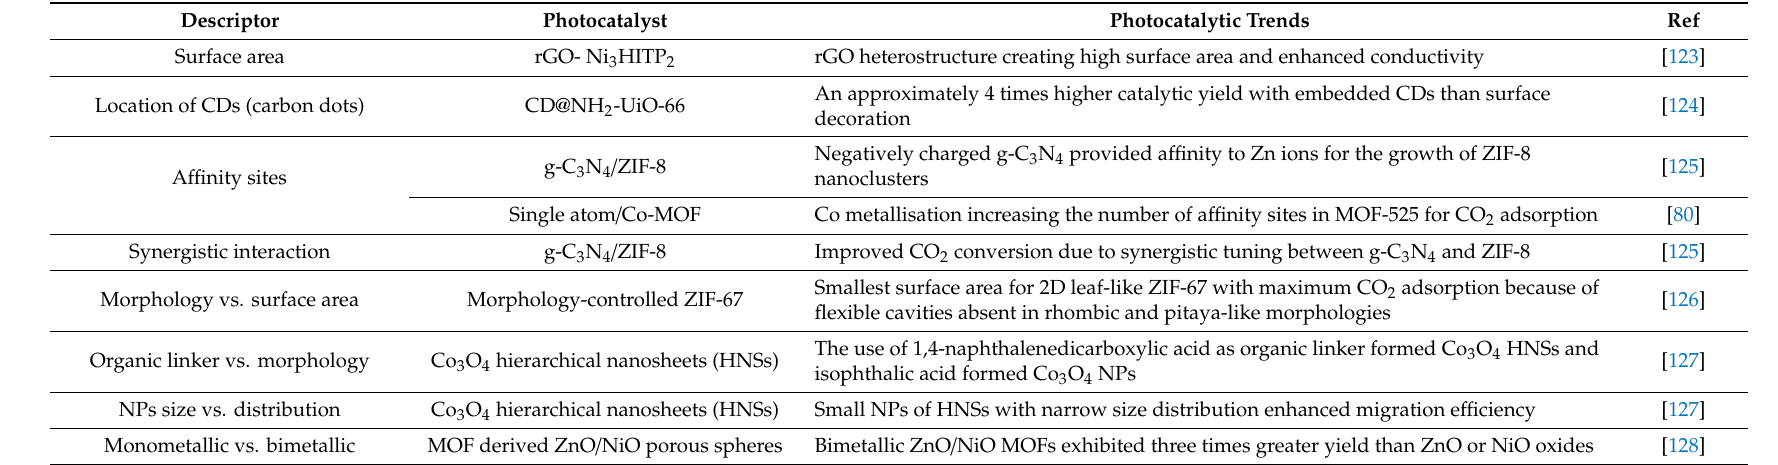
Table 7. Various catalytic descriptors summarising the photocatalytic trends in the miscellaneous species incorporated into MOFs for CO 2